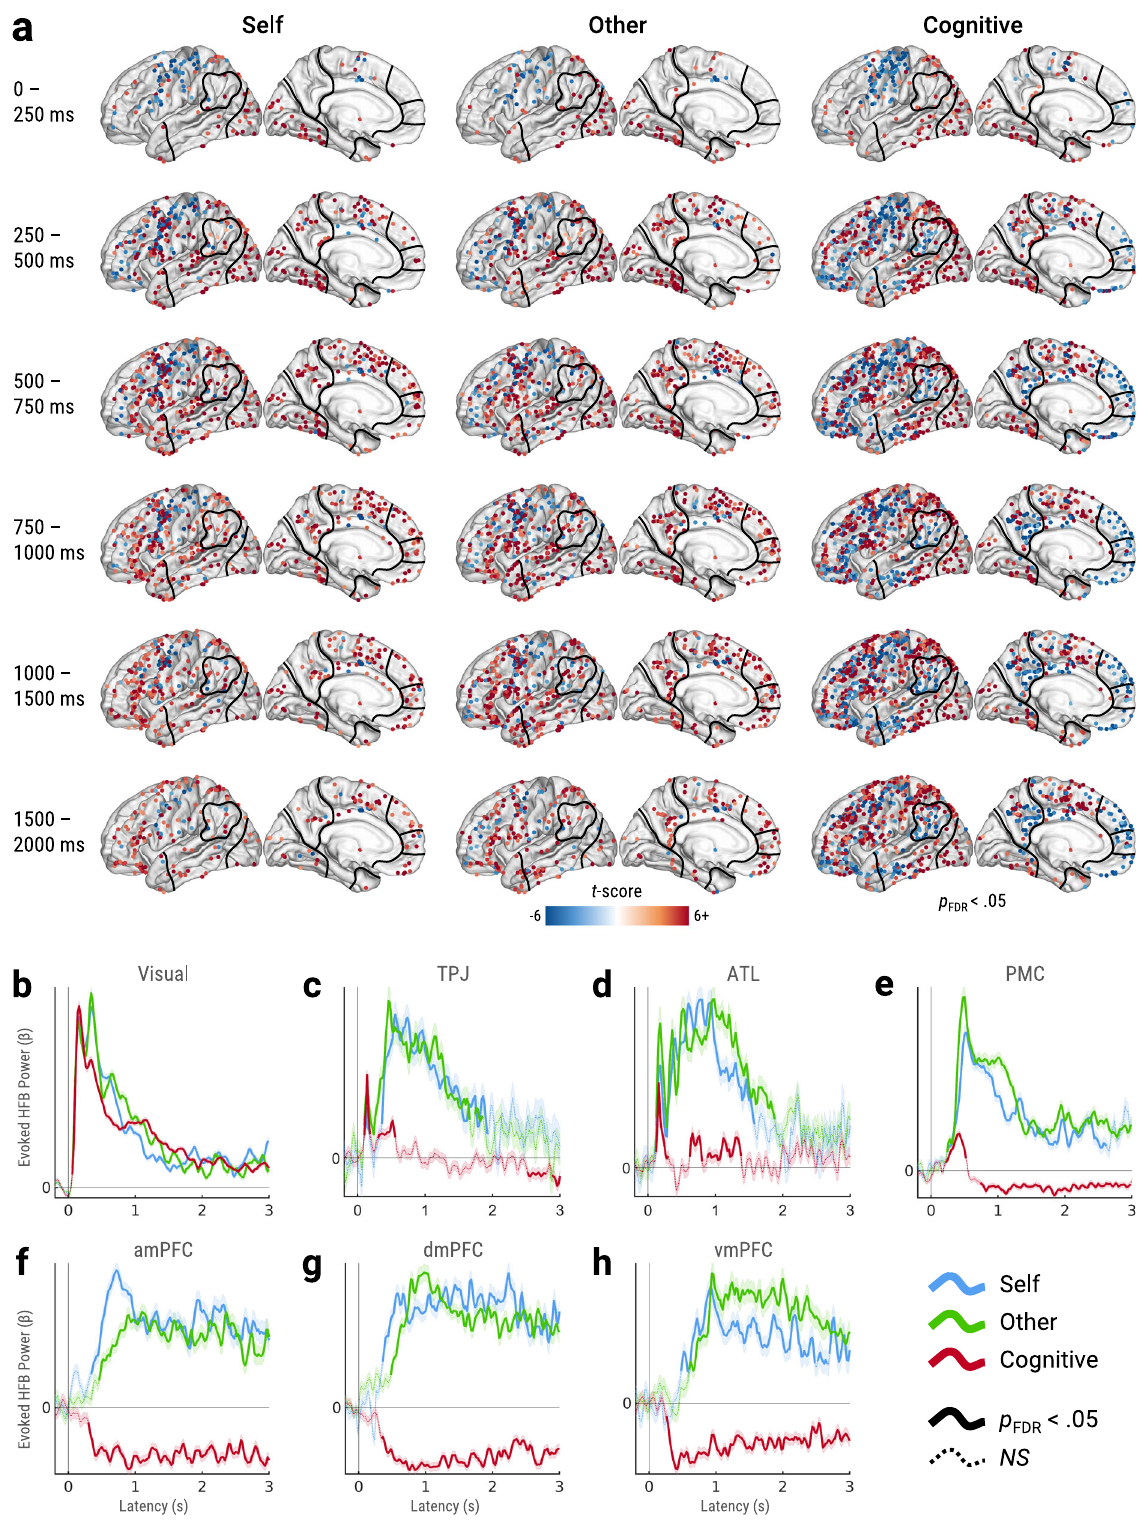
Fig. 6 Summary of evoked neuronal activity. a Sites with signi fi cant HFB responses during speci fi c time windows versus pre-stimulus baseline, colored by LMEM t -values ( p FDR < 0.05, corrected across sites and time windows, two-tailed). All sites plotted on left hemisphere with approximate ROI outlines. b – h Grand-average timecourses of evoked HFB power ( β ) within ROIs (LMEM-estimated). Thick solid lines indicate signi fi cant responses versus pre- stimulus baseline ( p FDR < 0.05, corrected across ROIs and timepoints, two-tailed). Thin dashed lines indicate nonsigni fi cant responses. Shaded areas indicate standard error of β . Abbreviations: HFB = high-frequency broadband (70 – 180 Hz), LMEM = linear mixed-effects model, ROI = region-of-interest, Visual = visual cortex, ATL = anterior temporal lobe, TPJ = temporoparietal junction, PMC = posteromedial cortex, amPFC = anteromedial prefrontal cortex, dmPFC = dorsomedial prefrontal cortex, vmPFC = ventromedial prefrontal cortex. Source data are provided as a Source Data fi